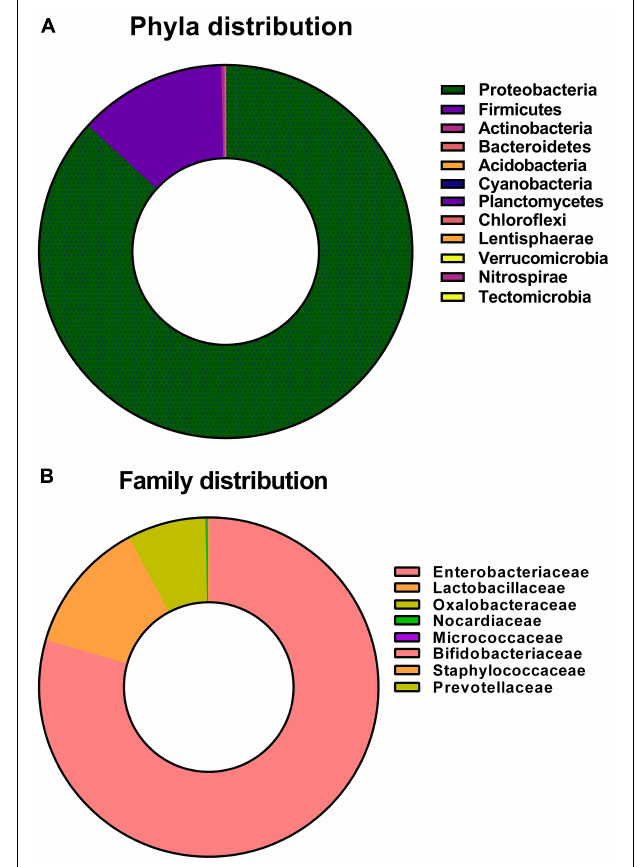
FIGURE 3 | Next-generation sequencing of culture-independent gut bacterial flora of A. florea . Taxa distributions of (A) phylum and (B) family at different phylogenetic levels of A. florea gut bacterial